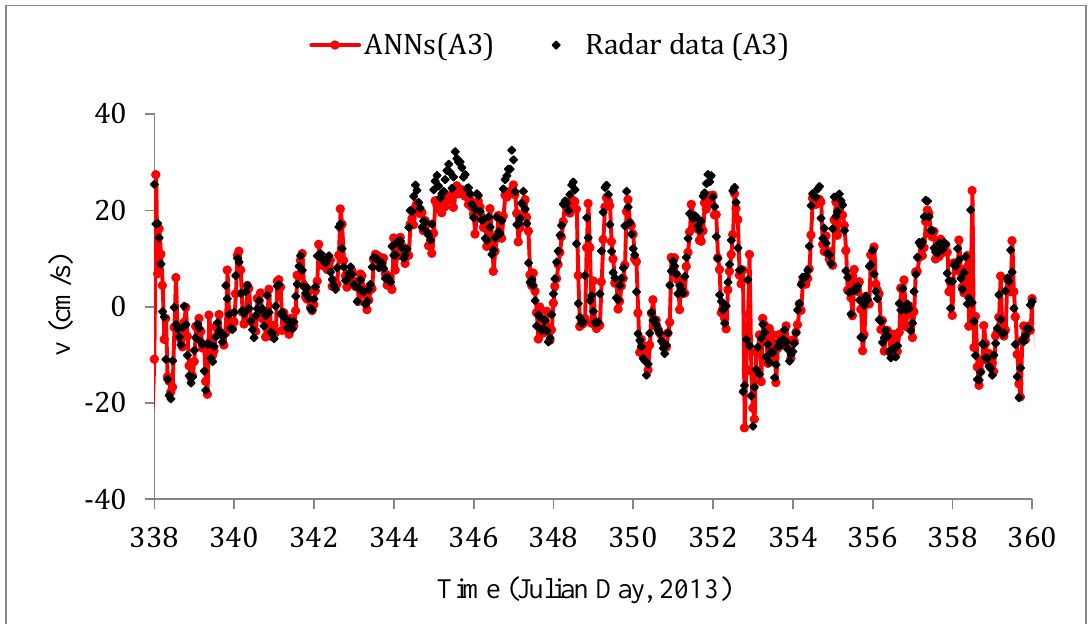
Figure 7. Forecasts of v velocity component at A3 (Model V9, 1 h forecast window).